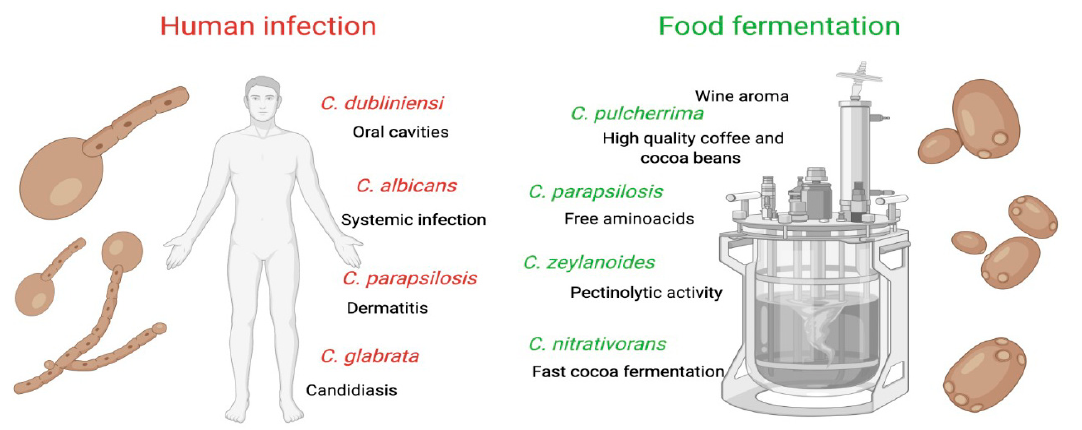
Figure 1. Candida species dual